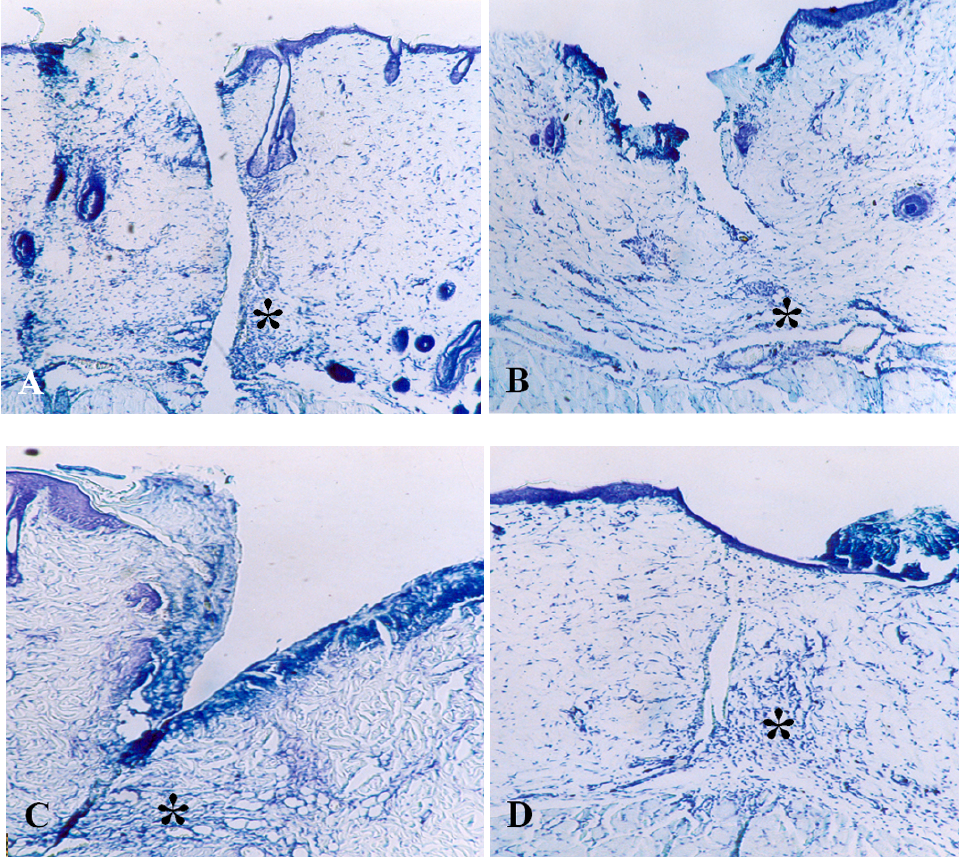
FIGURE 1 - Cross-sections of a surgical wound obtained from control animals at 2 ( A ) and 10 days ( B ) after the surgical procedure and from animals submitted to microcurrent application at 2 ( C ) and 10 days ( D ). The sections were stained with Toluidine blue. (*)Àrea of tissue healing. Final magnification: 200x